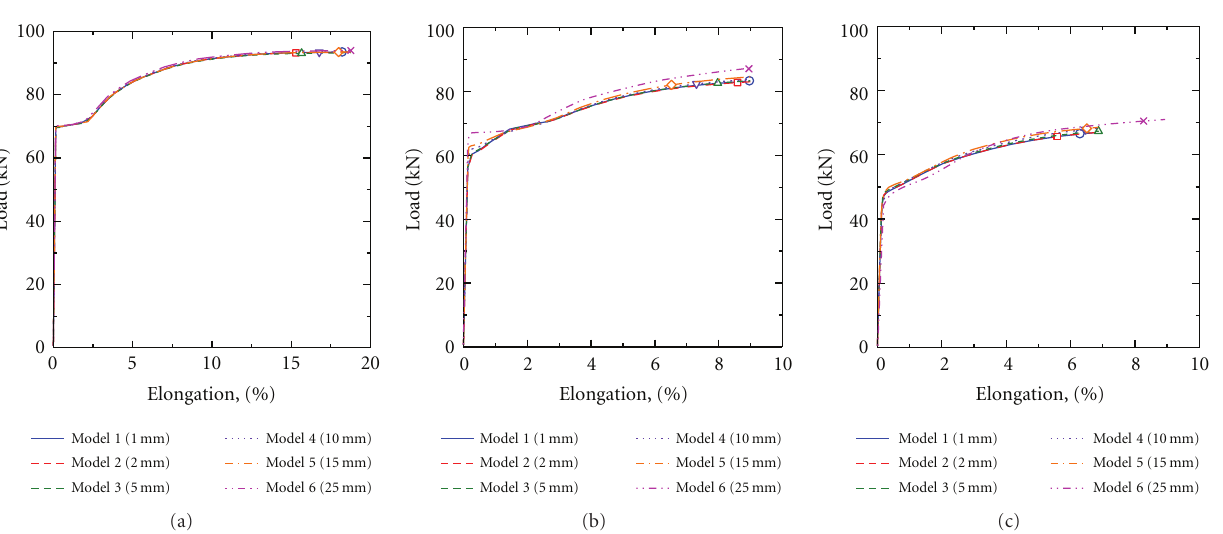
Figure 10: Comparison of load-elongation curves of RCSM models: (a) minor corrosion member FT-22, (b) moderate corrosion member FT-18, and (c) severe corrosion member